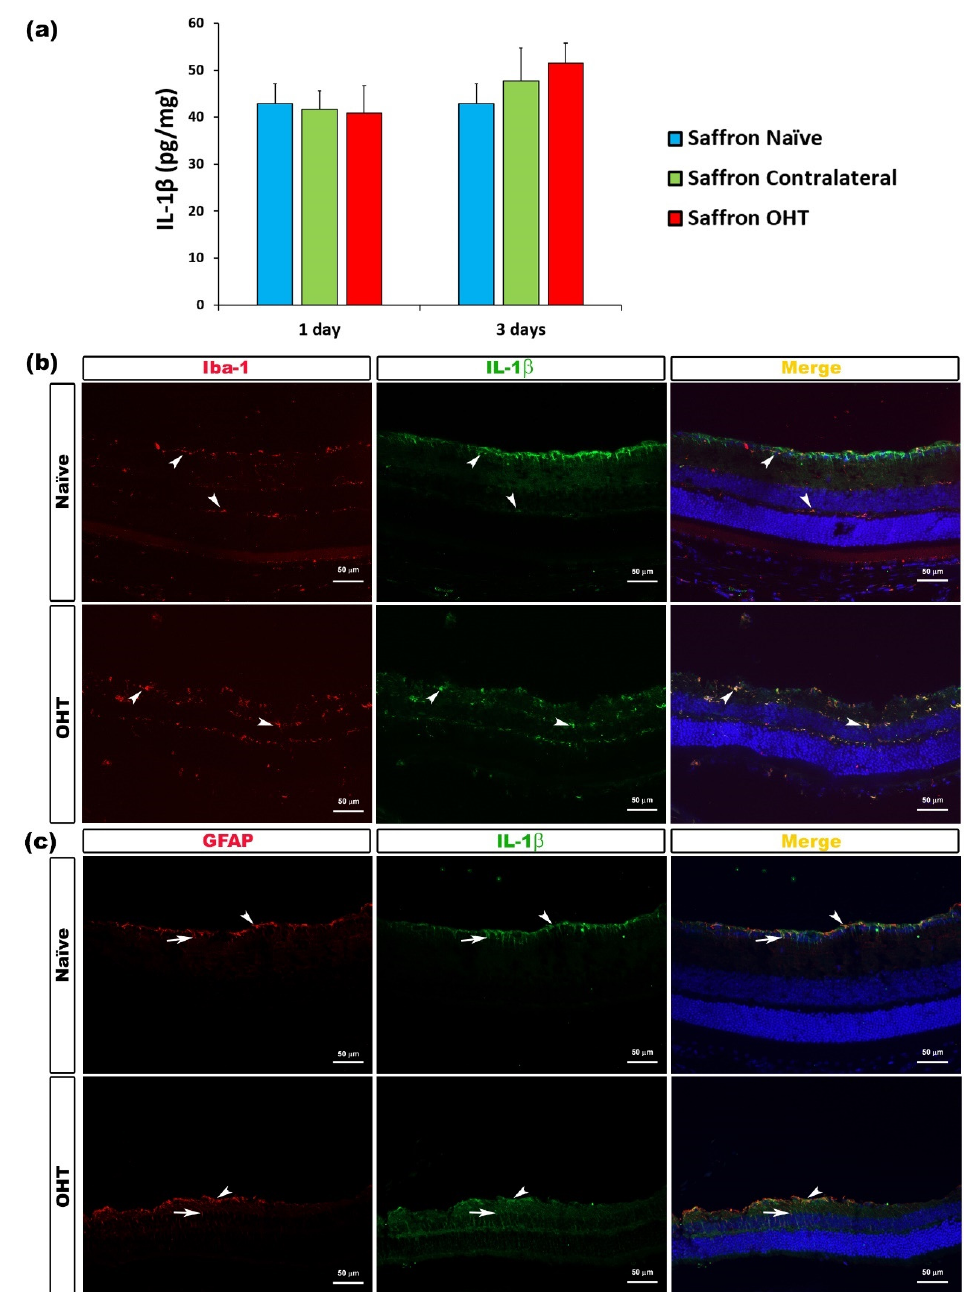
Figure 2. IL-1 β levels at 1 and 3 days after laser-induced ocular hypertension (OHT). ( a ) The IL-1 β values obtained in the multiplex assay. The histogram shows the mean levels (± SD) of IL-1 β (pg/mg) at days 1 and 3 after laser OHT induction, in saffron ocular hypertension eyes (saffron OHT), saffron-contralateral eyes (saffron-contralateral), and naïve eyes. ( b,c ) Immunohistochemical study of IL-1 β expression in naïve and saffron OHT eyes three days after unilateral laser-induced OHT. Retinal sections were immunolabeled with antibodies to IL-1 β (green), Iba-1 (red in ( b )), or GFAP (red in ( c )). The merge section is denoted with the colour yellow. ( b ) The arrowhead shows the co-expression of Iba-1 and IL-1 β . ( c ) Arrowhead (astrocytes) and arrow (Müller cells) indicate the co-expression of GFAP and IL-1 β . Abbreviations: OHT (ocular hypertension); IL-1 β (interleukin 1 beta); Iba-1 (ionized calcium-binding adaptor molecule); GFAP (glial fibrillary acidic protein).